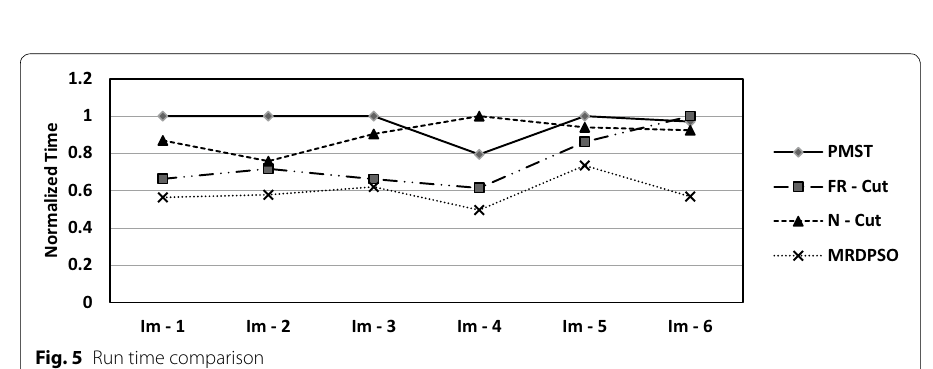
Fig. 4 a GCE for test images (Barkley Dataset). b LCE for test images (Barkley Dataset)